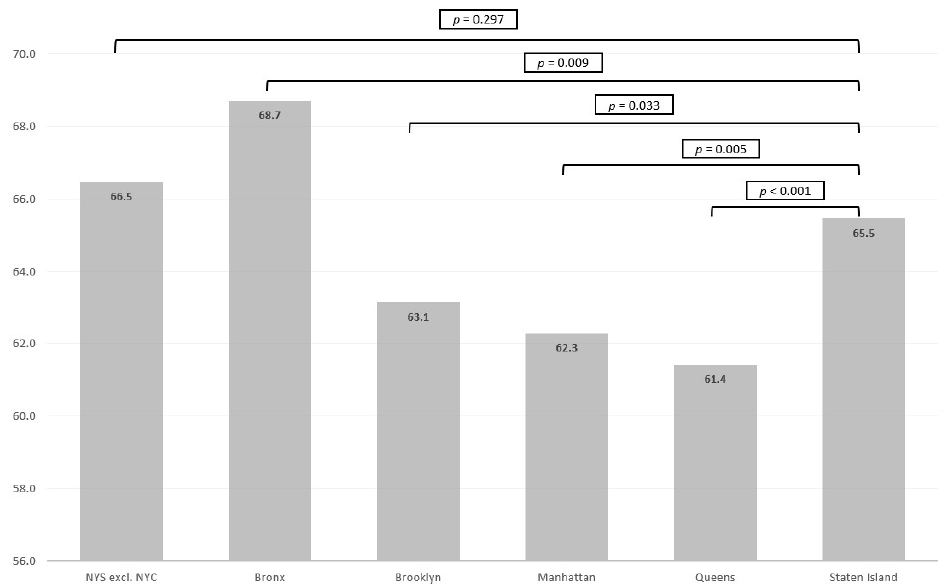
Figure 4. Percentage of local stage/in situ thyroid cancer per geographical region.